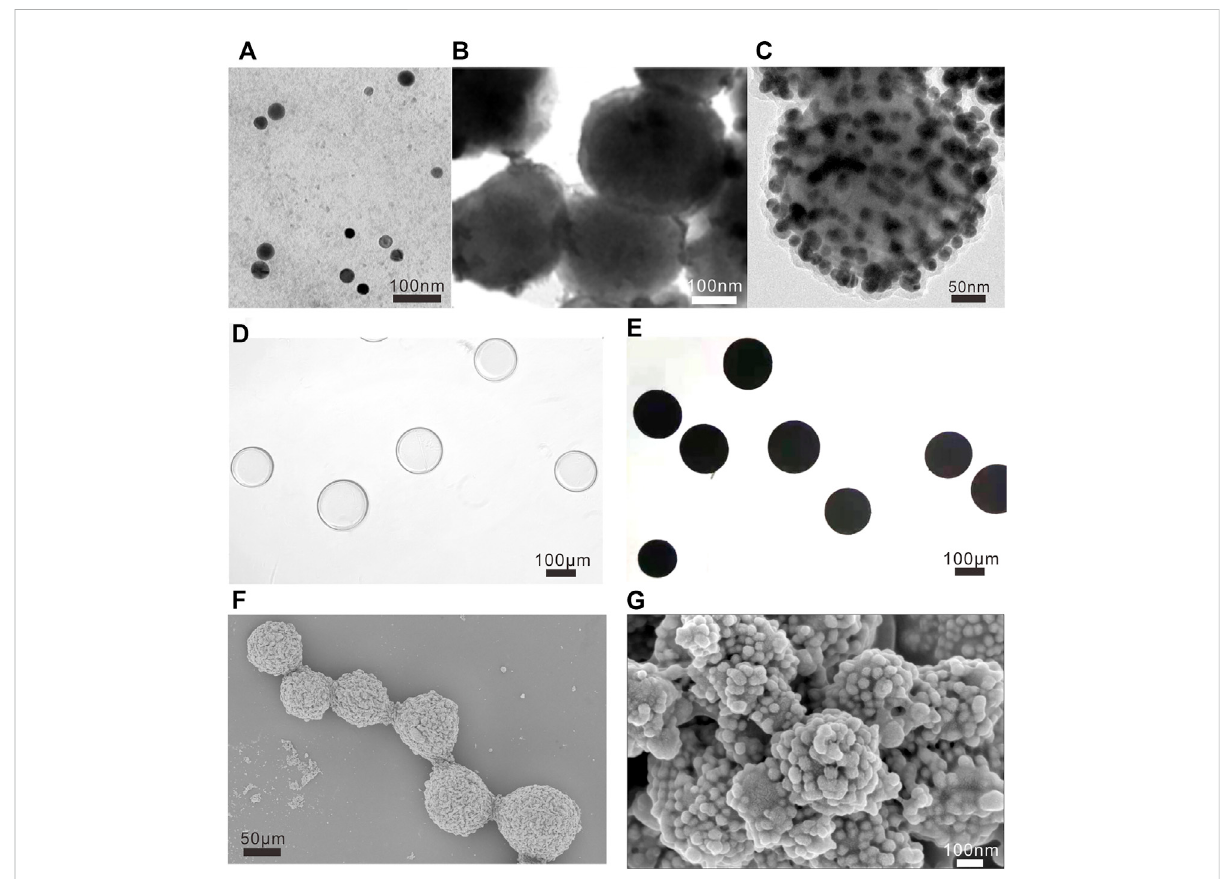
FIGURE 2 Characterization of NAMs. TEM images of (A) Au nanoparticles, (B) Fe 3 O 4 nanoparticles and (C) small spheres, and the scalebar is 100 nm in (A,B) ,and50 nmin (C) .MorphologiesofEmbospheresbefore (D) andafter (E) assemblywithsmallspheresunderopticalmicroscope.Thescalebaris 100 μ mfor (D,E) .Representativelow-resolutionSEMimage[ (F) ,thescalebaris50 μ m]andhigh-resolutionSEMimages[ (G) ,thescalebaris100 nm] of